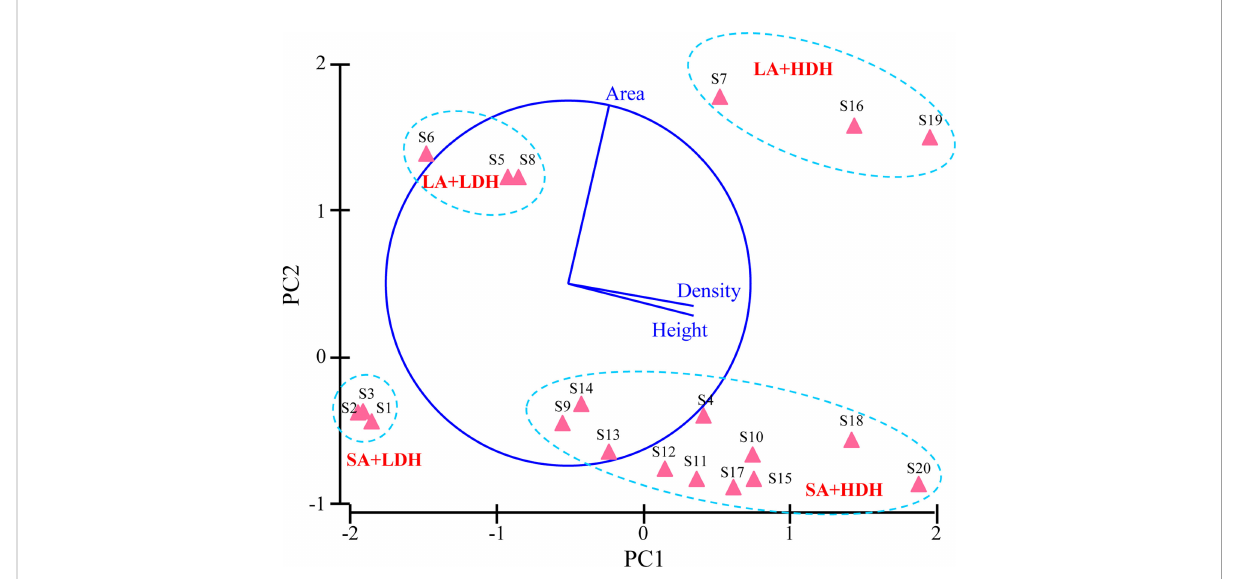
FIGURE 1 Principal component analysis (PCA) depicting the extent of differences in seagrass canopy structure among all sampling patches. PC1 = 50.5% variation and PC2 = 32.4%